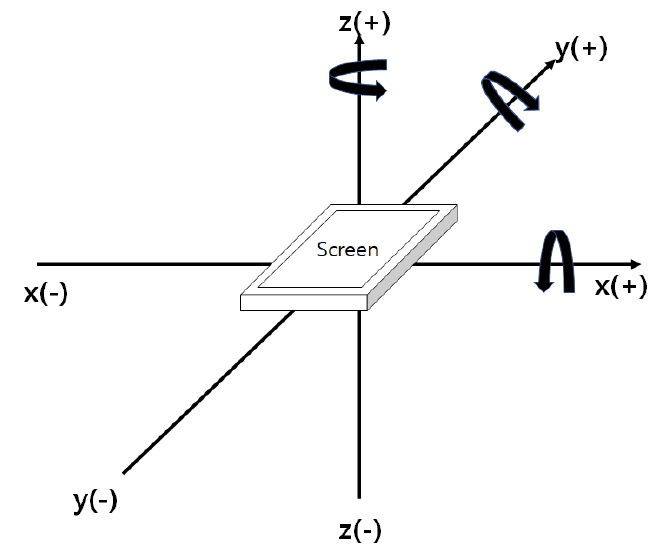
Figure 2. Smartphone reference axis for motion